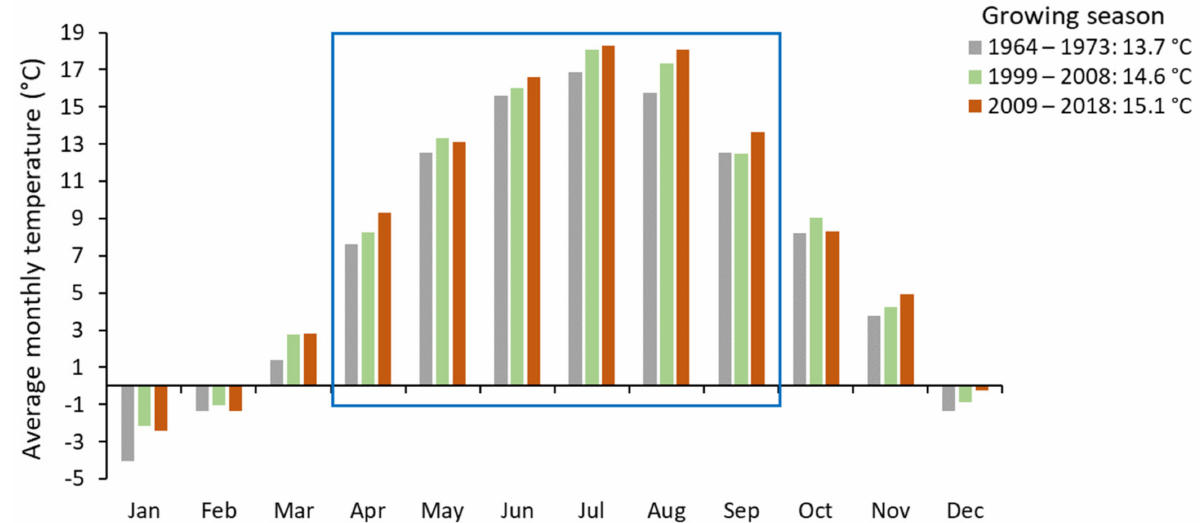
Figure 5. Average monthly temperature in the periods 1966–1975, 1999–2008 and 2009–2018 based on climate data from the Lesko weather station (420 m a.s.l.). The blue frame encloses months falling within the growing